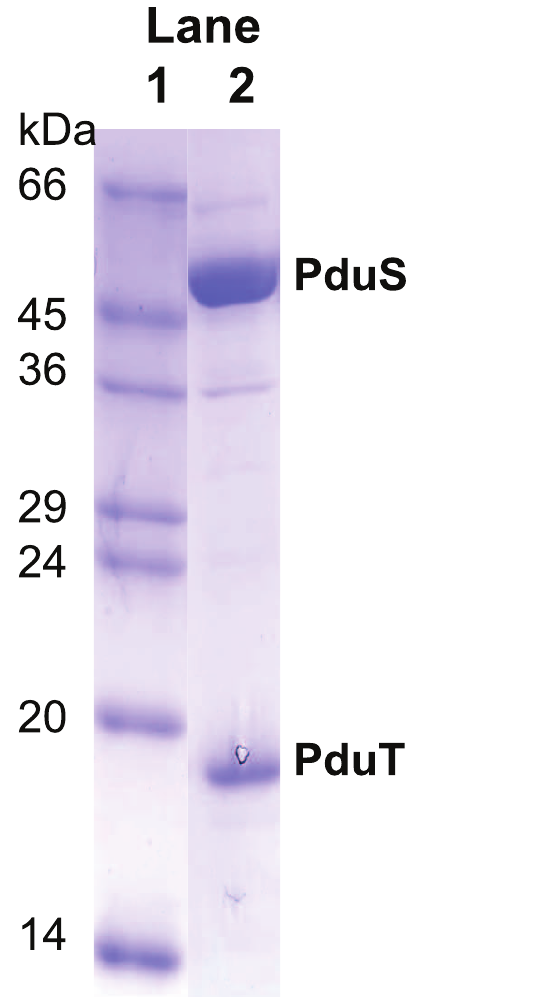
Figure 6. SDS-PAGE of PduS/PduT copurification. Lane 1 contains molecular mass markers as indicated. Lane 2 contains the purification eluate from a nickel column that has been applied with the crude cell extract of a strain overproducing His-tagged PduS and untagged PduT. The identities of PduS and PduT were confirmed by MALDI after trypsin digestion of the extracted protein bands.